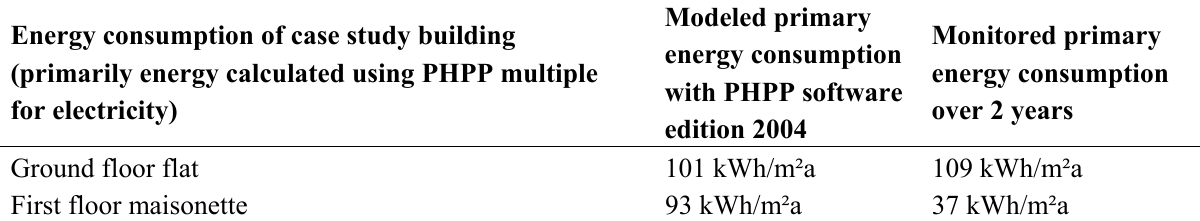
Table 4. Energy consumption of case study